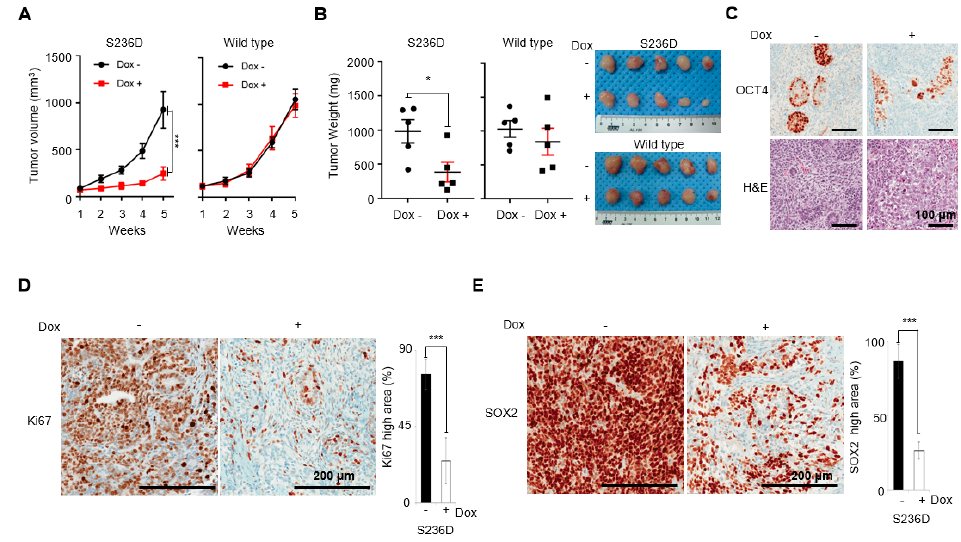
Figure 4. GCT cells expressing a mimic of p-OCT4 (S236) instead of endogenous OCT4 exhibit reduced growth and increased differentiation in vivo. ( A ) Difference in xenograft volumes between WT and S236D tumor. When the volume of the tumor mass reached 50–100 mm 3 , five mice were randomly selected for doxycycline induction with the rest for the vehicle-treated control group. With tumor size being measured for five weeks, doxycycline-treated xenografts showed significantly lower tumor volumes (N = 5, *** p < 0.001). ( B ) Final weight of tumor mass between WT and S236D. Graphs represent the mean ± standard error of the mean ( n = 5; * p < 0.05). Images of tumors are shown on the right. ( C ) Immunohistochemistry with anti-OCT4 antibody indicates decreased OCT4 expression in Dox-treated samples. H&E: hematoxylin and eosin. ( D ) Ki67 staining shows that the proliferation is reduced in Dox-treated S236D. The degree of Ki67 staining was quantified by calculating the areas showing more than 50% Ki-67-positive cell percentage within xenograft explants. *** p < 0.001 relative to Dox nontreated S236D. ( E ) Reduced SOX2 expression in Dox-treated S236D. The degree of SOX2 staining was quantified by calculating the areas showing strong SOX2-positivity within xenograft explants. *** p < 0.001 relative to Dox nontreated